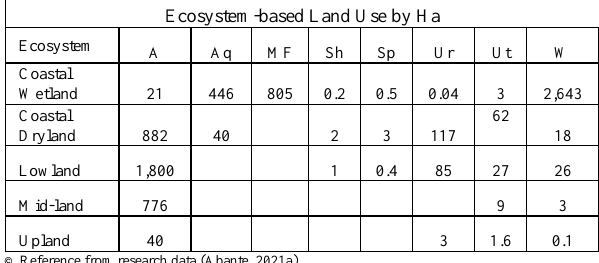
Table 1 – Ecosystem-based Land Use Supply in Ha 2.4.2 Sub-watershed -based land use supply analysis: Table 2